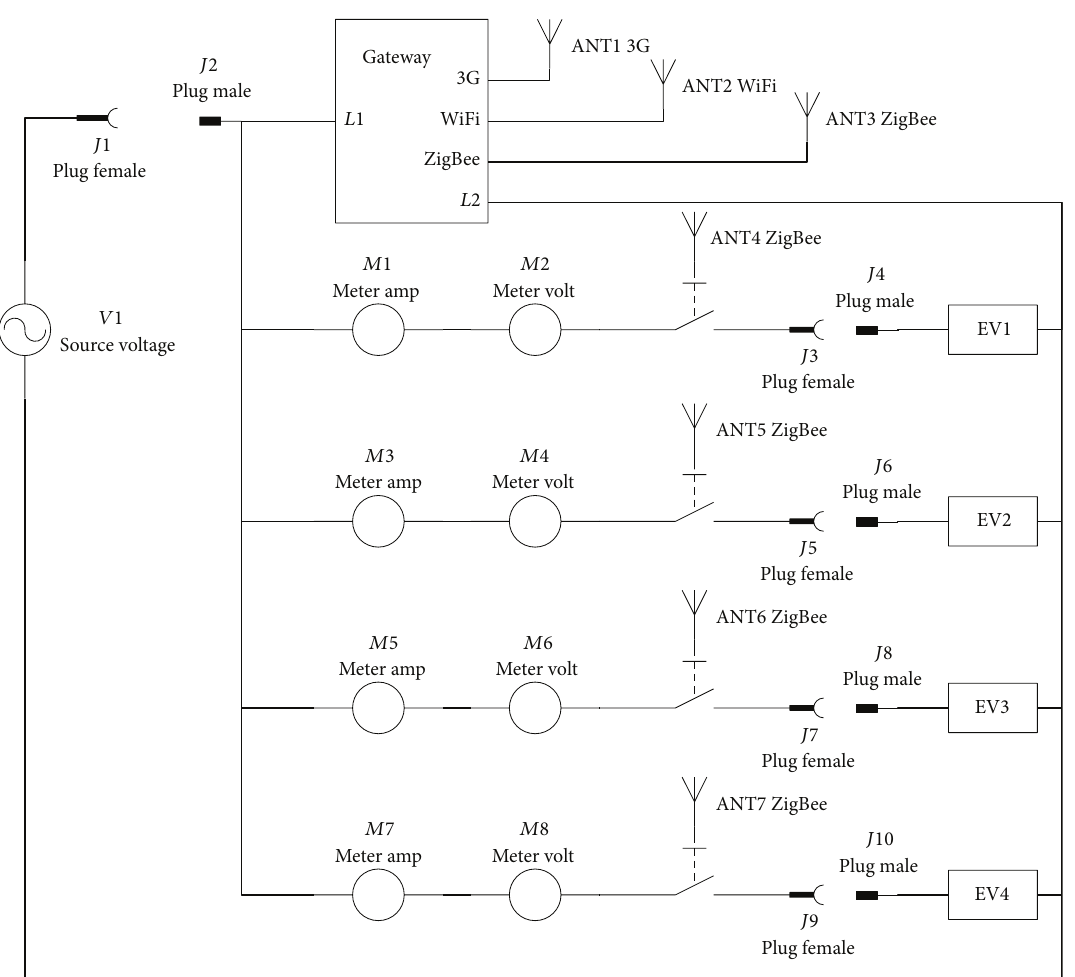
Figure 3: Schematics of metering